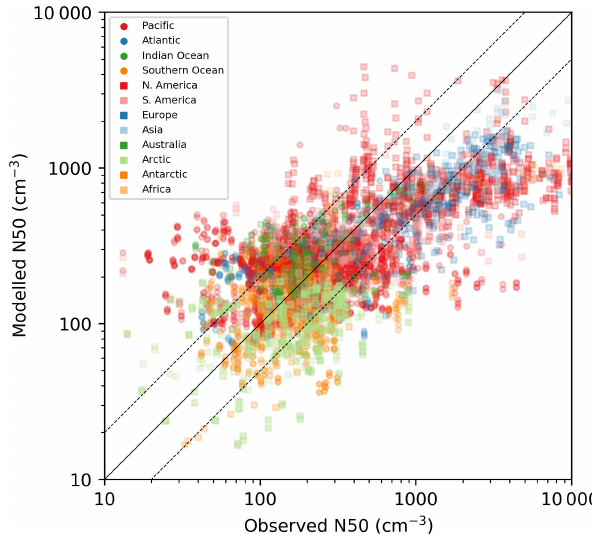
Figure 8. Monthly mean simulated N50 from the simulation pre- sented in Fig. 7 versus observations from campaign and ground station data collated via the Global Aerosol Synthesis and Science Project (see references for details; GASSP, 2017; Reddington et al., 2017). For a detailed description of the data sets used, see Ap- pendix A. The data are harmonised and averaged to monthly means (assuming that observations are representative of the month) and compared with the model on the model grid. Different colours and symbols denote data from different